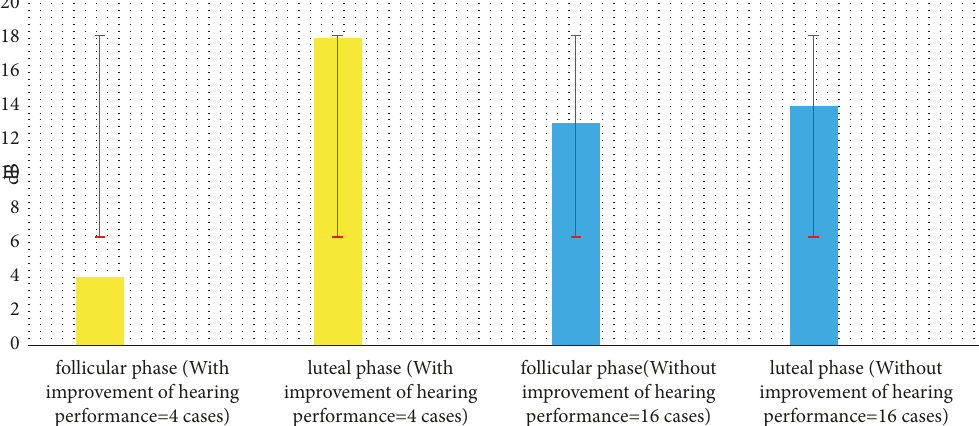
Figure 2: Mean hearing thresholds 250 HZ of twenty healthy female in follicular-luteal phase.